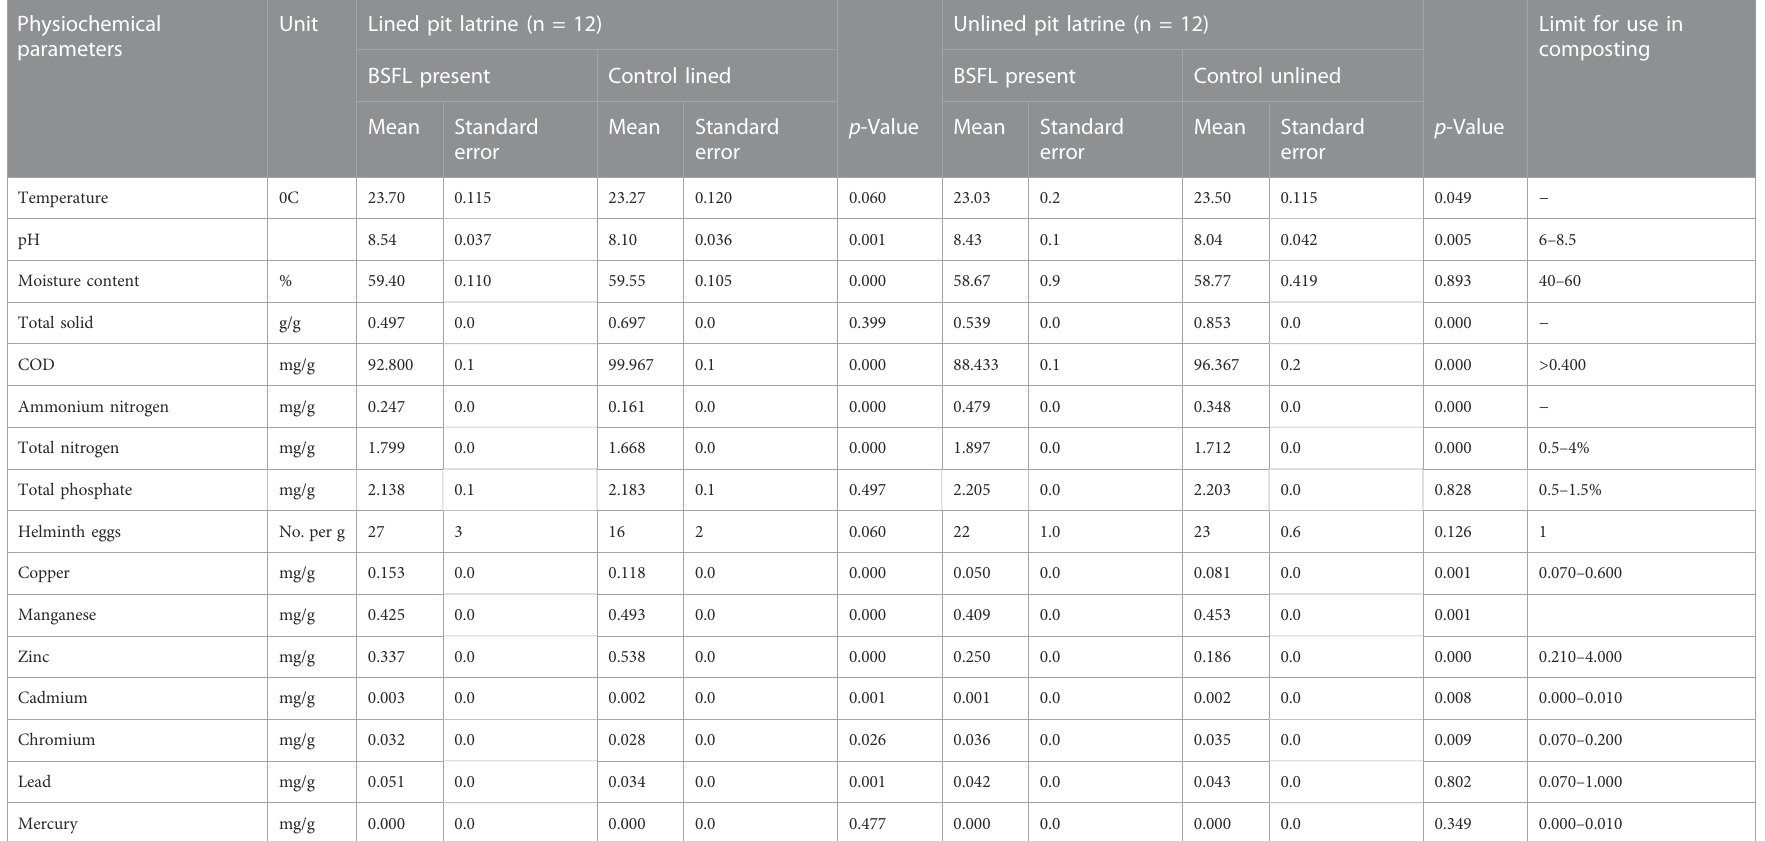
TABLE 3 Characteristics of the residues of faecal sludge from lined and unlined pit latrines after BSFL treatment. Physiochemical